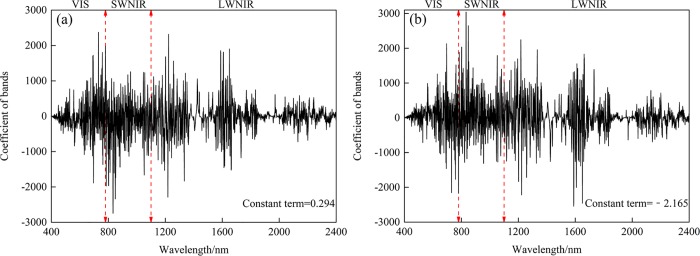
Coefficients of all bands and the constant term of the spectral reflectance model (a) and the absorbance model (b). Note: VIS denotes visible spectroscopy (400–780 nm), SWNIR and LWNIR denote shortwave and longwave near infrared spectroscopy (780–1100 nm and 1100–2526 nm, respectively). Red line denotes the borderline of range of VIS, SWNIR and LWNIR.